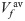
Contour plot of flexural rigidity.The flexural rigidity, Dc, of the cylindrical FGMs for different values of Vfav is presented. The arrows indicate the maximal point of Dc in the c¯1-c¯2 space. See text for the details of the parameter settings.